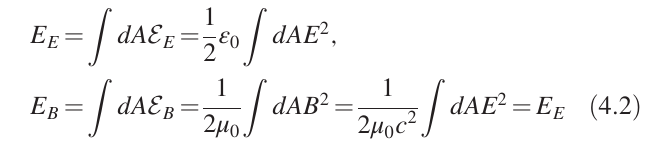
.FIG. 10. The horizontal gradient of the electrical field ∂ E in the quadrupole mode at the center as a function of ð b=a; θ 0 Þ . The horizontal axes are labeled as in Fig. 7, the vertical axes shows the gradient in units of V the plates. The beam pipe radius a ¼ 25 mm. The geometric mean of the characteristic impedance Z along each